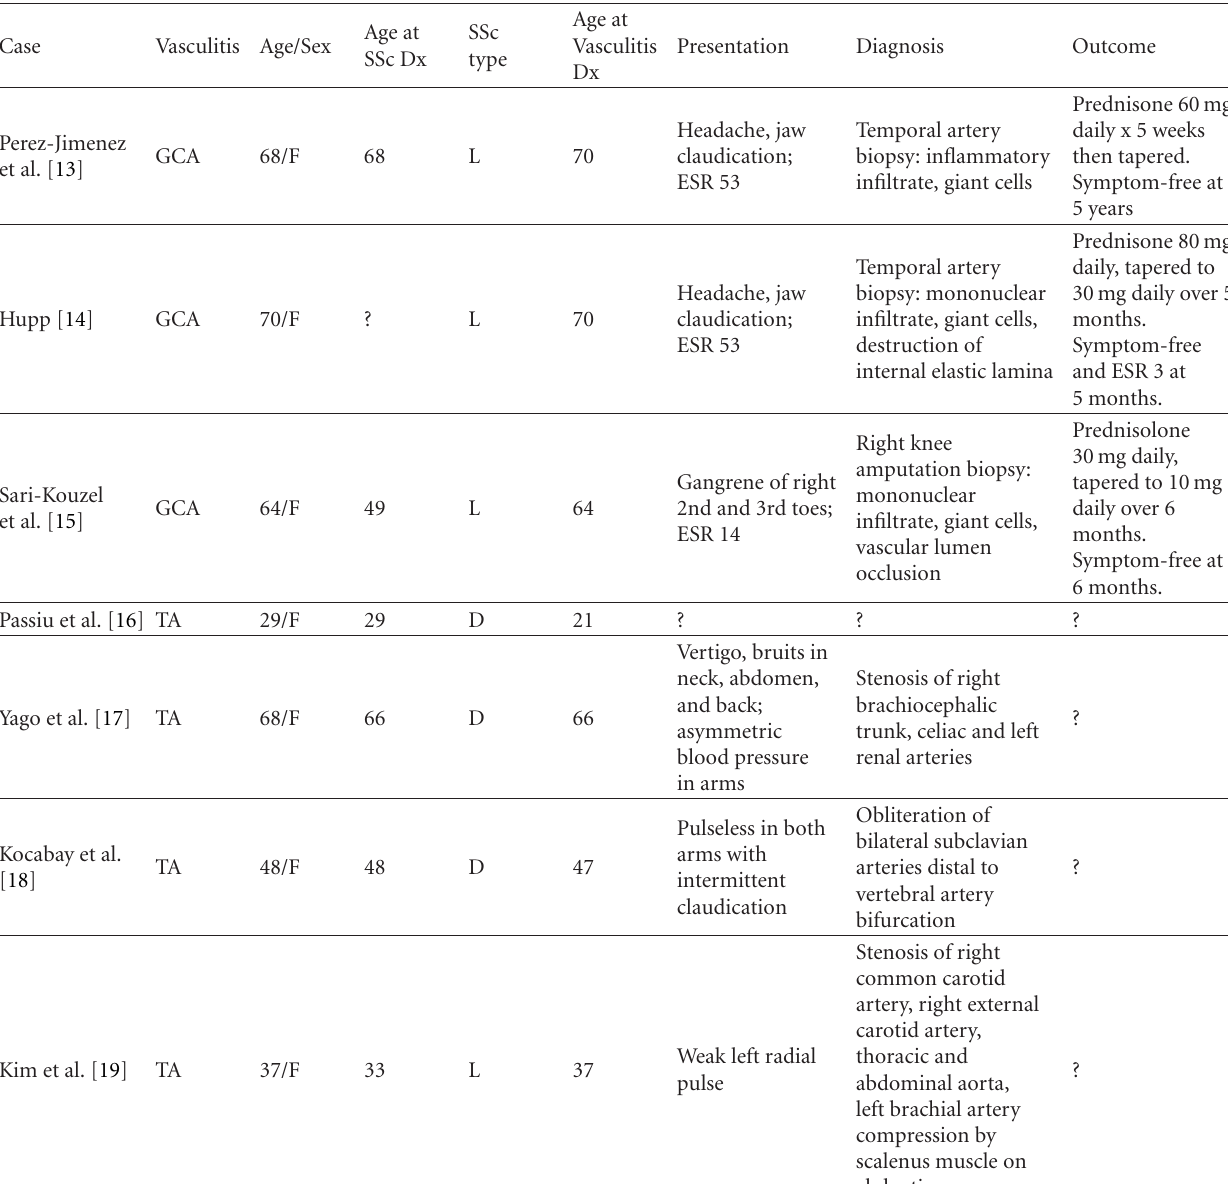
Table 1: Seven cases of large-vessel vasculitis associated with